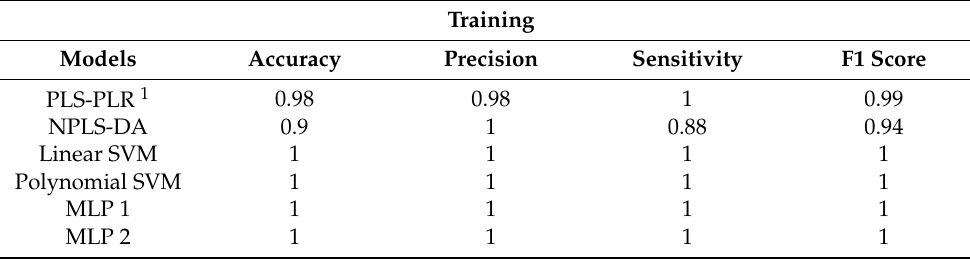
Table 2. Comparative table of models evaluation metrics in the training phase.